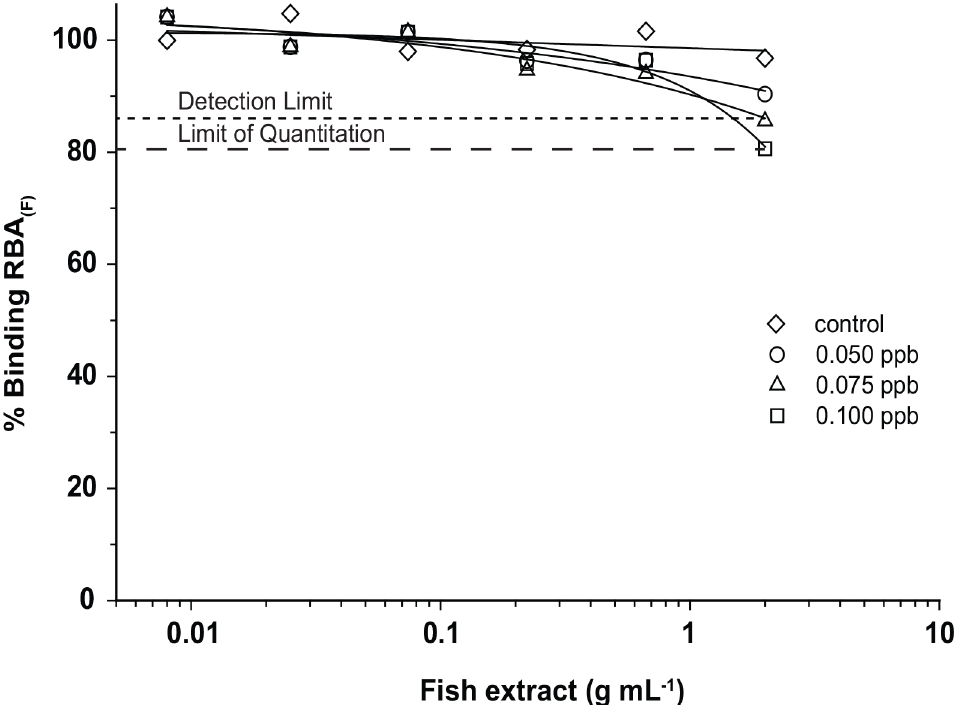
Fig 3. RBA (F) Sample Binding Curves. Representative RBA (F) curves of 1:3 serially diluted of fish samples spiked with 0 (open diamond), 0.050 (open circle), 0.075 (open triangle), and 0.100 ppb (open square) P-CTX-3C with percent (%) binding versus fish extract concentration (g mL -1 ). The detection limit (small dashed line) was 0.075 ppb P-CTX-3C and the limit of quantitation (larger dashed line) was 0.100 ppb P-CTX-3C.